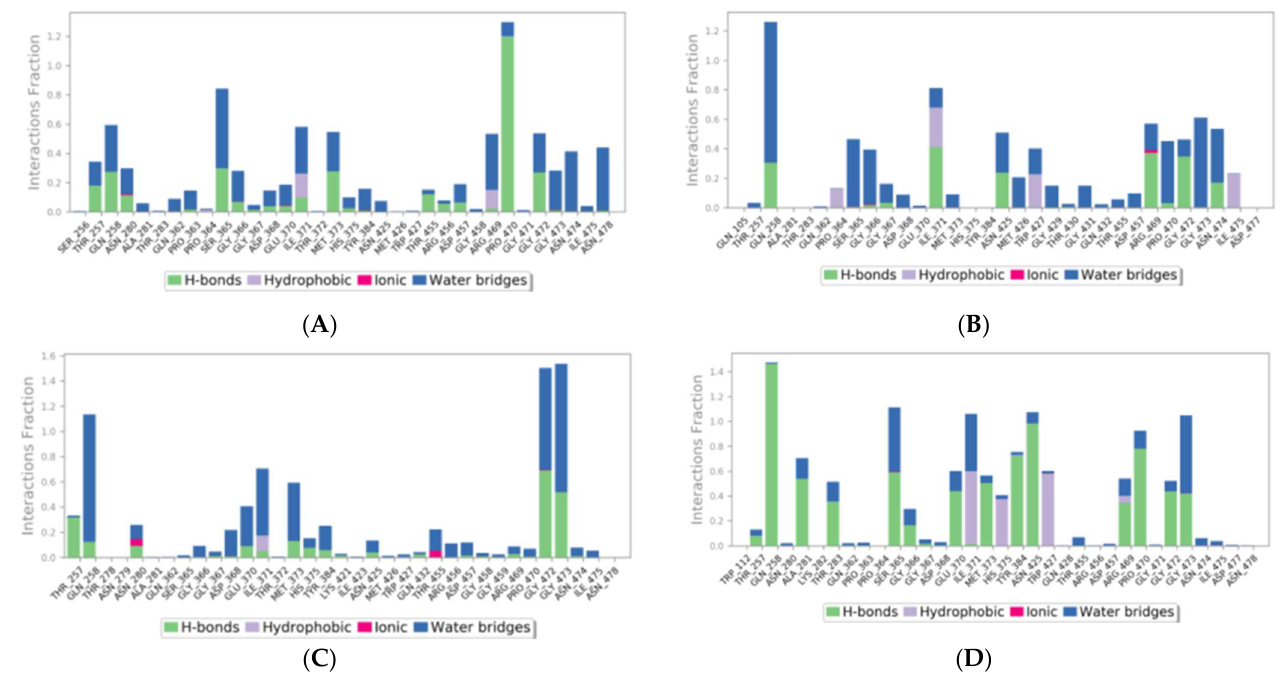
Figure 6. Analysis of the molecular interactions and the type of contacts with clade A/E throughout MD simulation. Normalized stacked bar chart of clade A/E residues interacting with ( A ) NP-005114, ( B ) NP-007382, ( C ) NP-007422, and ( D ) NP-008297. Hydrogen bonds, hydrophobic bond, ionic interactions, and water bridges are represented as green, grey, red, and blue, respectively.